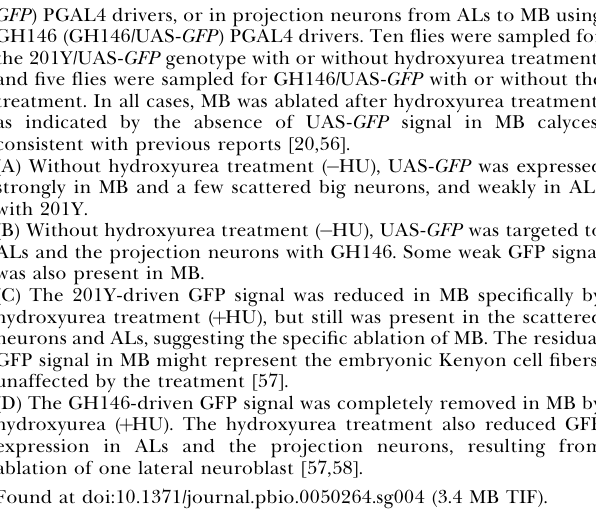
Figure S5. Knockdown of the G a q Protein